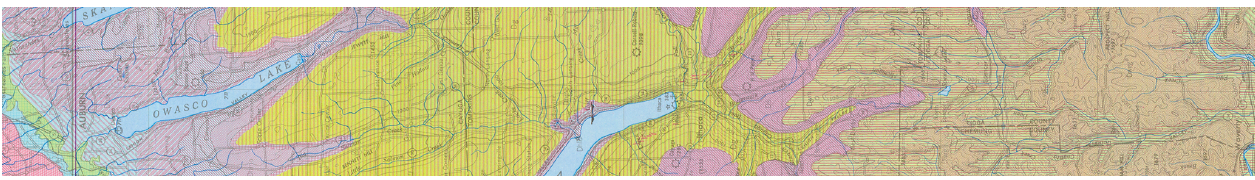
showing the SSURGO map unit composition (Fig. 4). The map unit is described by its constituent soil series and their estimated proportions. Each series can then be queried for its OSD (NRCS Soils, 2020b), which gives a typical profile, a range of properties, and a link to lab data for the series. In